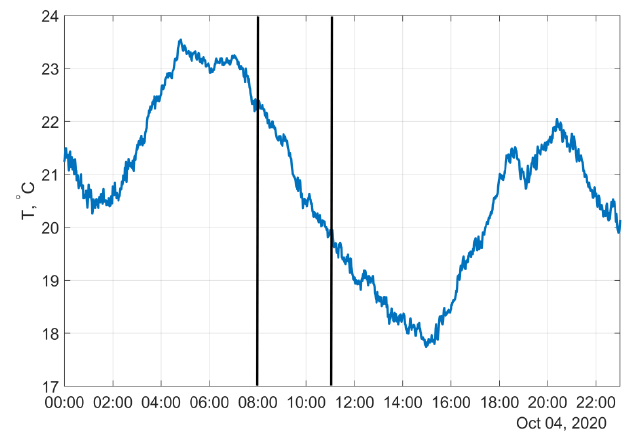
Figure 11. The temperature variability during the eddy passage, according to LTS records. The time axis is LT.